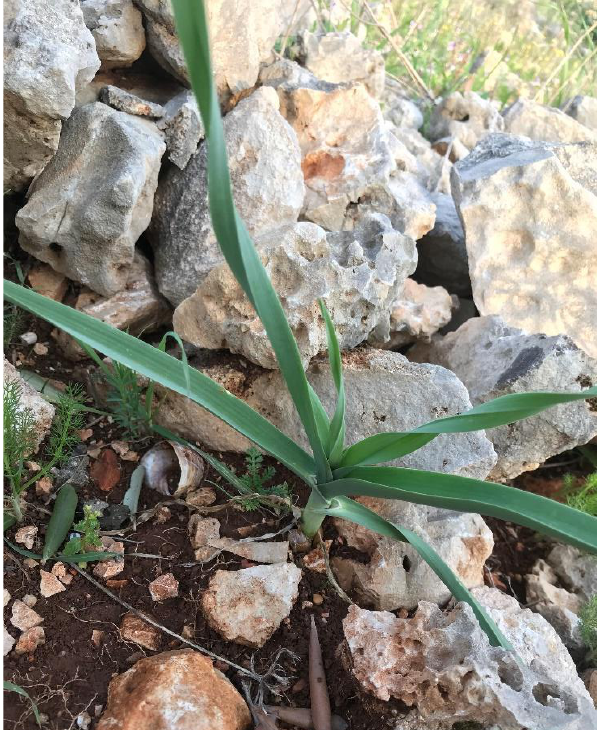
Figure 4. Allium ampeloprasum ; (Photo: Sulaiman N).